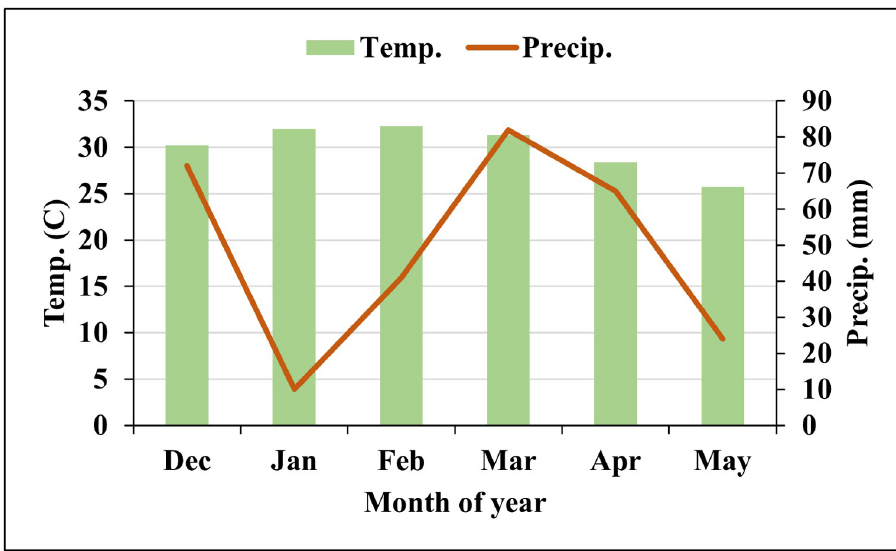
Fig 2. The temperature and precipitation of the study area during the experiment period (15/12/2018- 31/05/ 2019). Note that Temp. and Precip. denote the monthly average maximum temperature and total precipitation